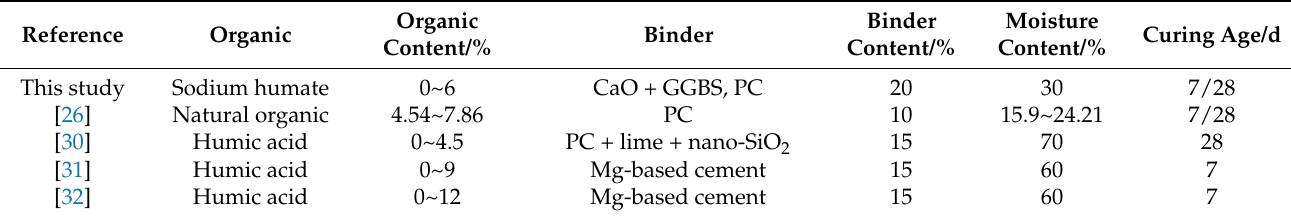
Table 5. Comparison of different conditions for treating organic-rich